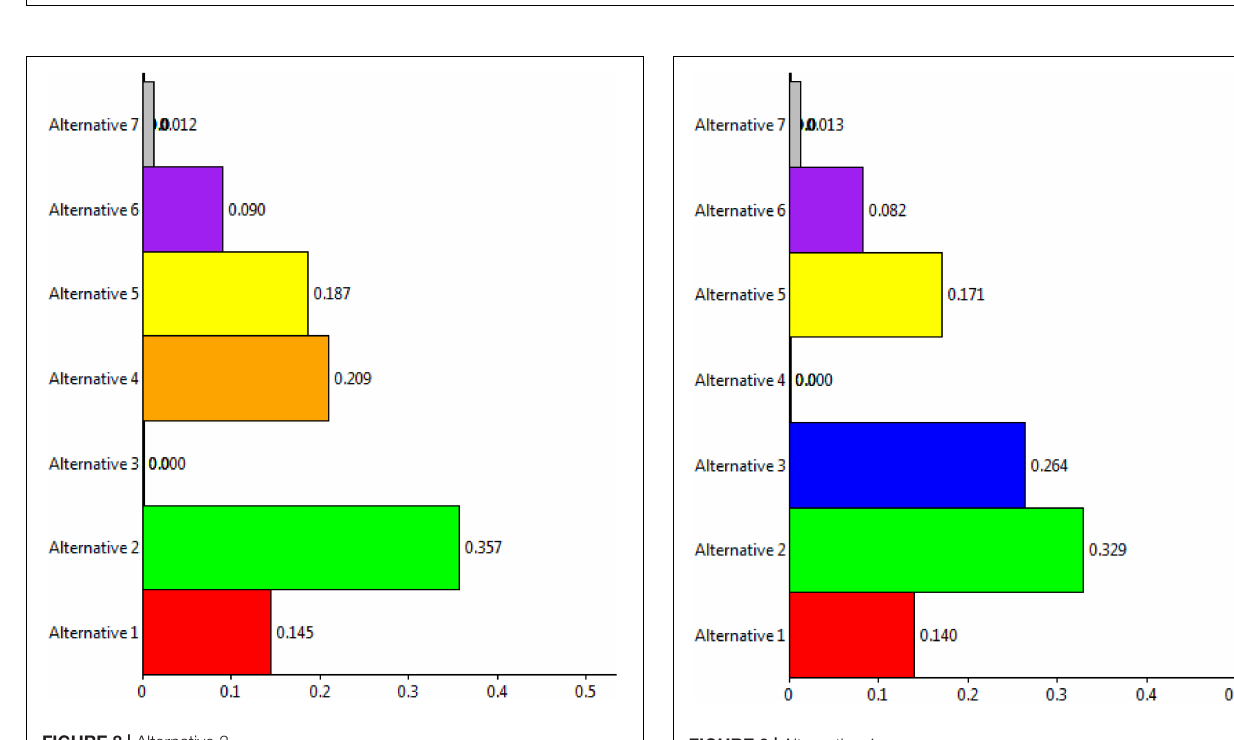
FIGURE 7 | Alternative 2.